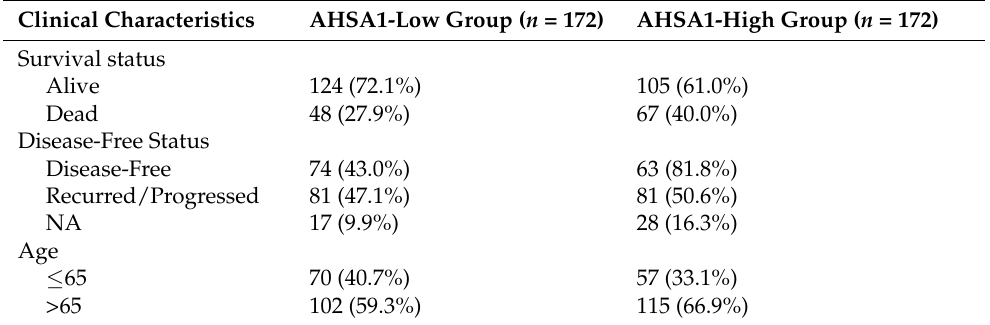
Table 1. Clinical characteristics in HCC patients with AHSA1-high expression or AHSA1-low expression in TCGA-LIHC